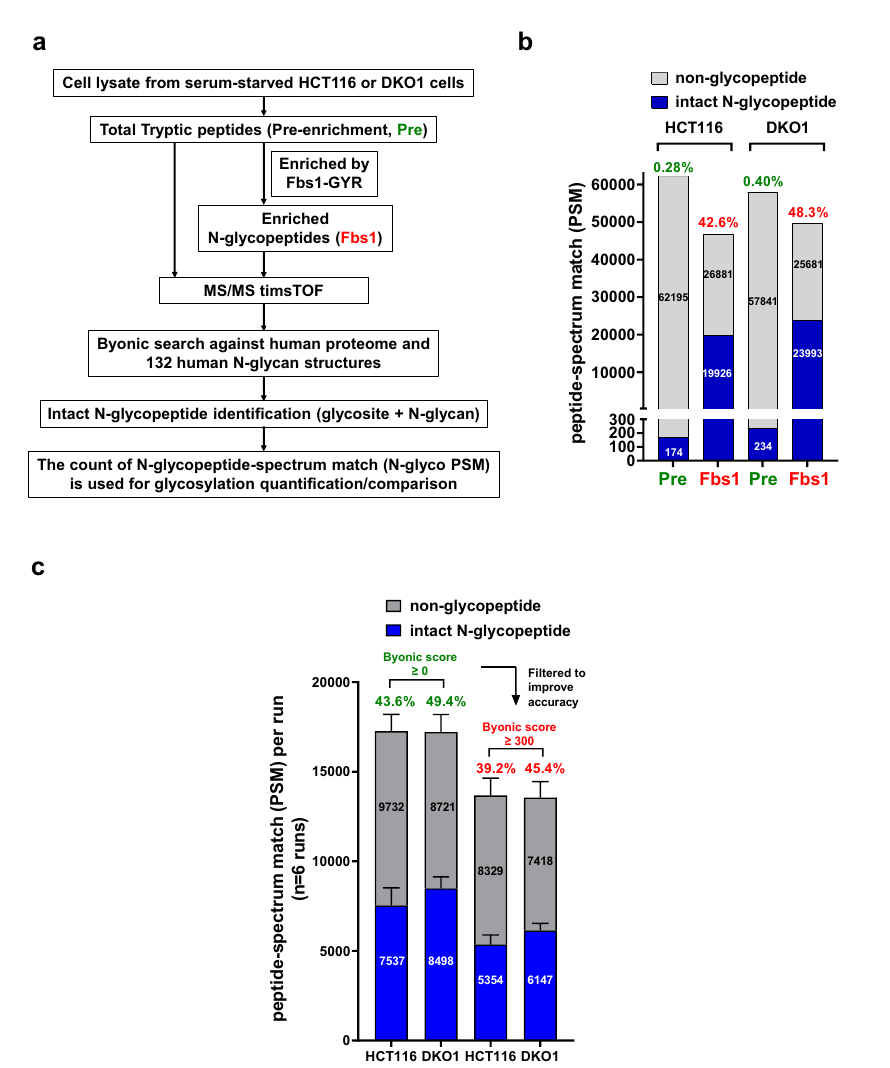
Fig. 1 Combination of Fbs1-GYR enrichment and timsTOF enables large-scale N-glycoproteome identi fi cation from HCT116 and DKO1 cell lysates. a The work fl ow for N-glycoproteome identi fi cation. b Fbs1-GYR enables more than 100-fold N-glycopeptide enrichment. Pre, pre-enrichment, samples were not enriched by Fbs1-GYR; Fbs1, samples were enriched by Fbs1-GYR. The data shown is from MS/MS with 45 min LC. c Filtering with Byonic score ≥ 300 improves the MS accuracy. The data shown is a combination of six MS/MS runs with 45 min LC and 90 min LC. Detailed information can be found in Supplemental Data 1 –